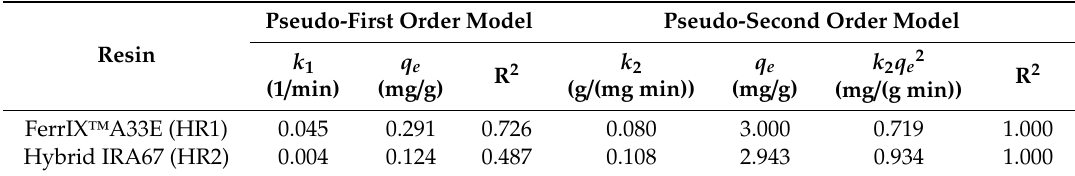
Table 3. Parameters of kinetic equations to model the P adsorption kinetic data in hybrid resins. q e is the adsorption capacity of adsorbents (mg / g) at equilibrium. k 1 (g / mg / hr) is the first order rate constant. k 2 (g / mg / hr) is the second order rate constant.